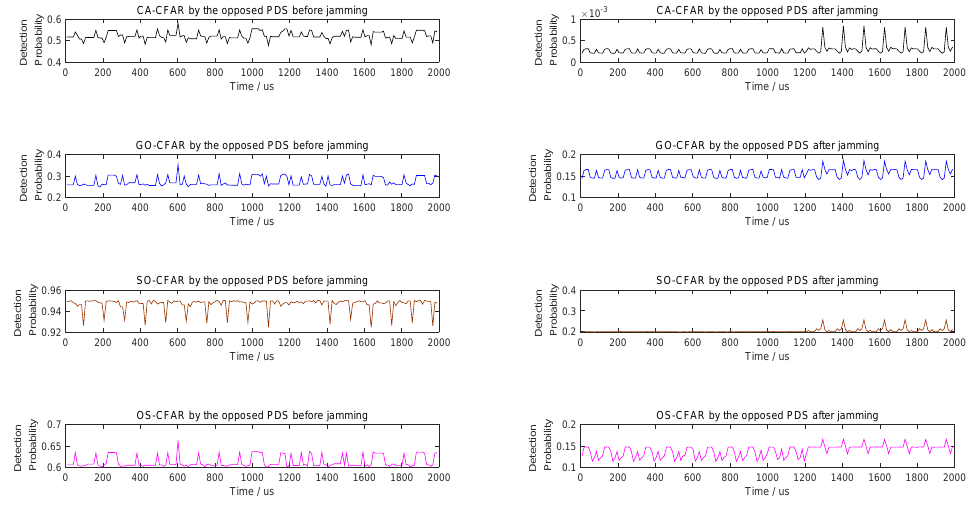
Figure 4. Detection probability of CA, GO, SO, and OS-CFAR before and after jamming when the number of reference units is